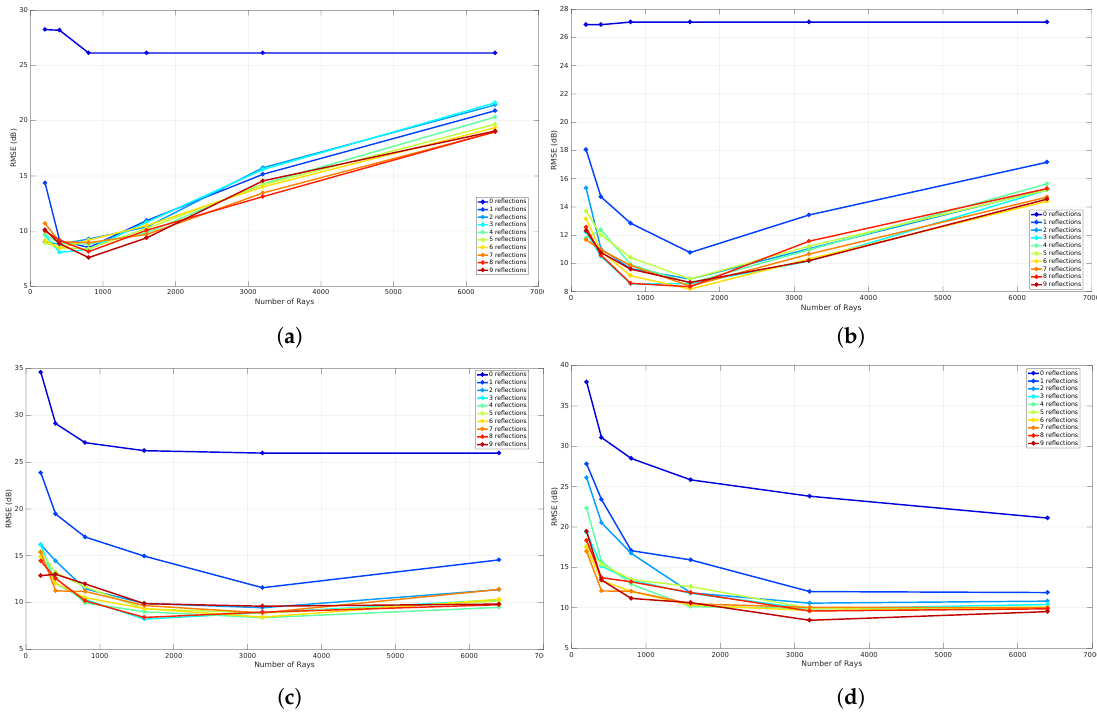
Figure 20. Reflection benchmark for office environment 1. ( a ) reflection benchmark at level 6; ( b ) reflection benchmark at level 7; ( c ) reflection benchmark at level 8; ( d ) reflection benchmark at level